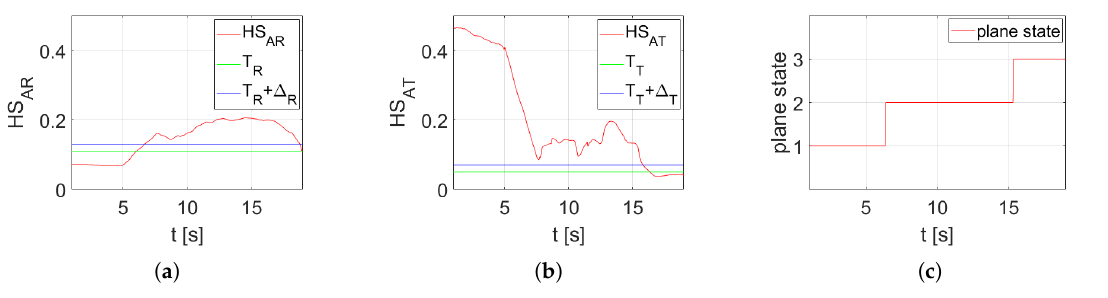
Figure 14. Graphs obtained for the selected test video: ( a ) HS AR = f ( t ) , ( b ) HS AT = f ( t ) , ( c ) plane